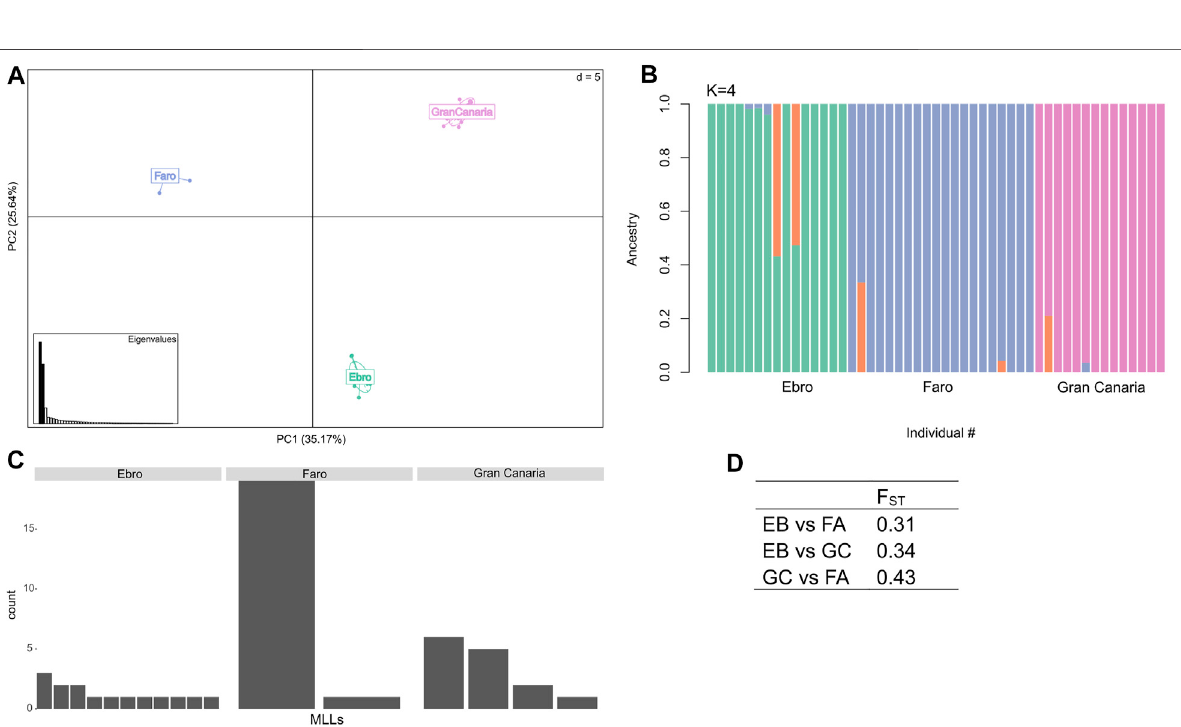
Frontiers in Genetics |